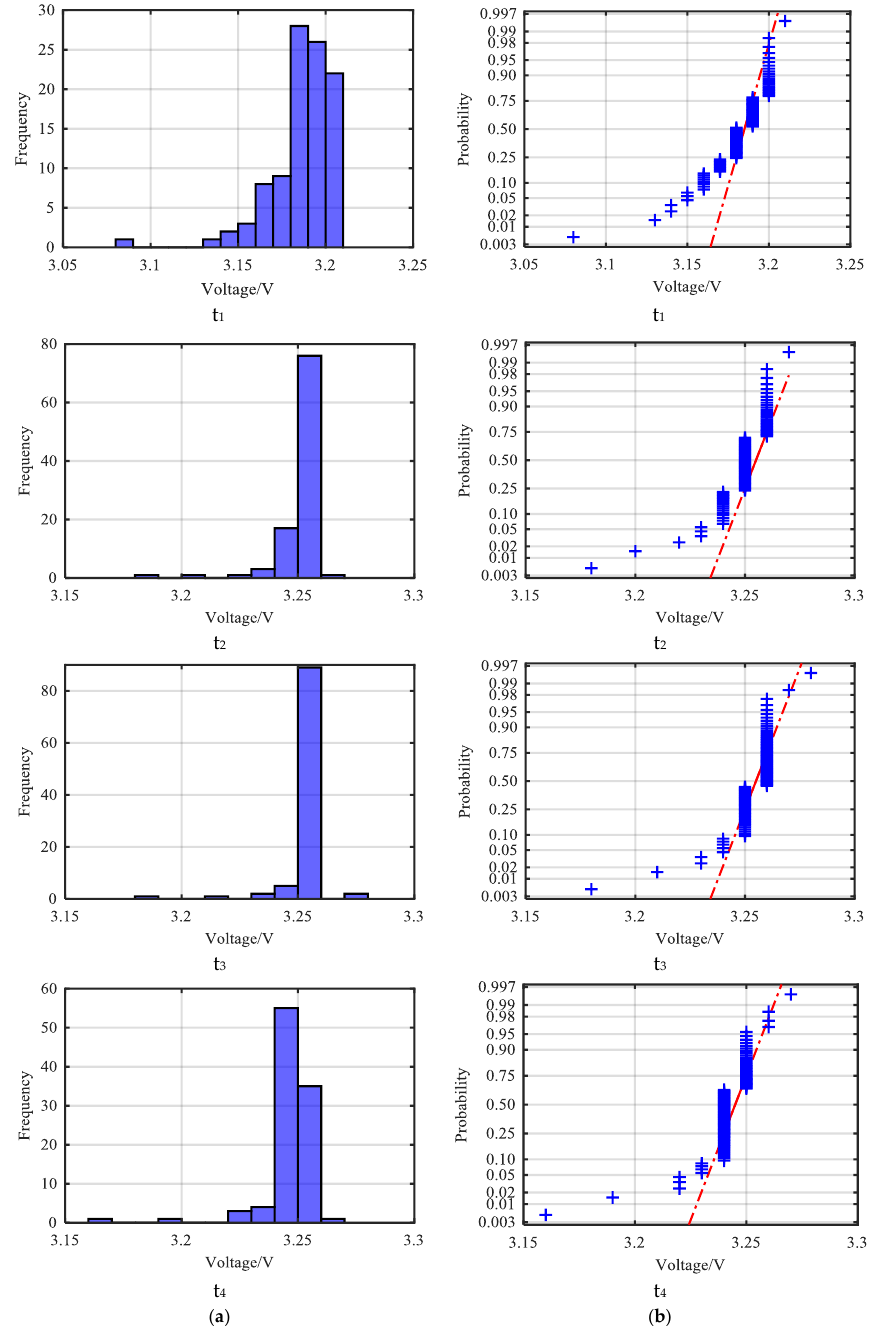
Figure 6. ( a ) The histogram of the frequency distribution at different time; ( b ) The normal distribution test at different time.